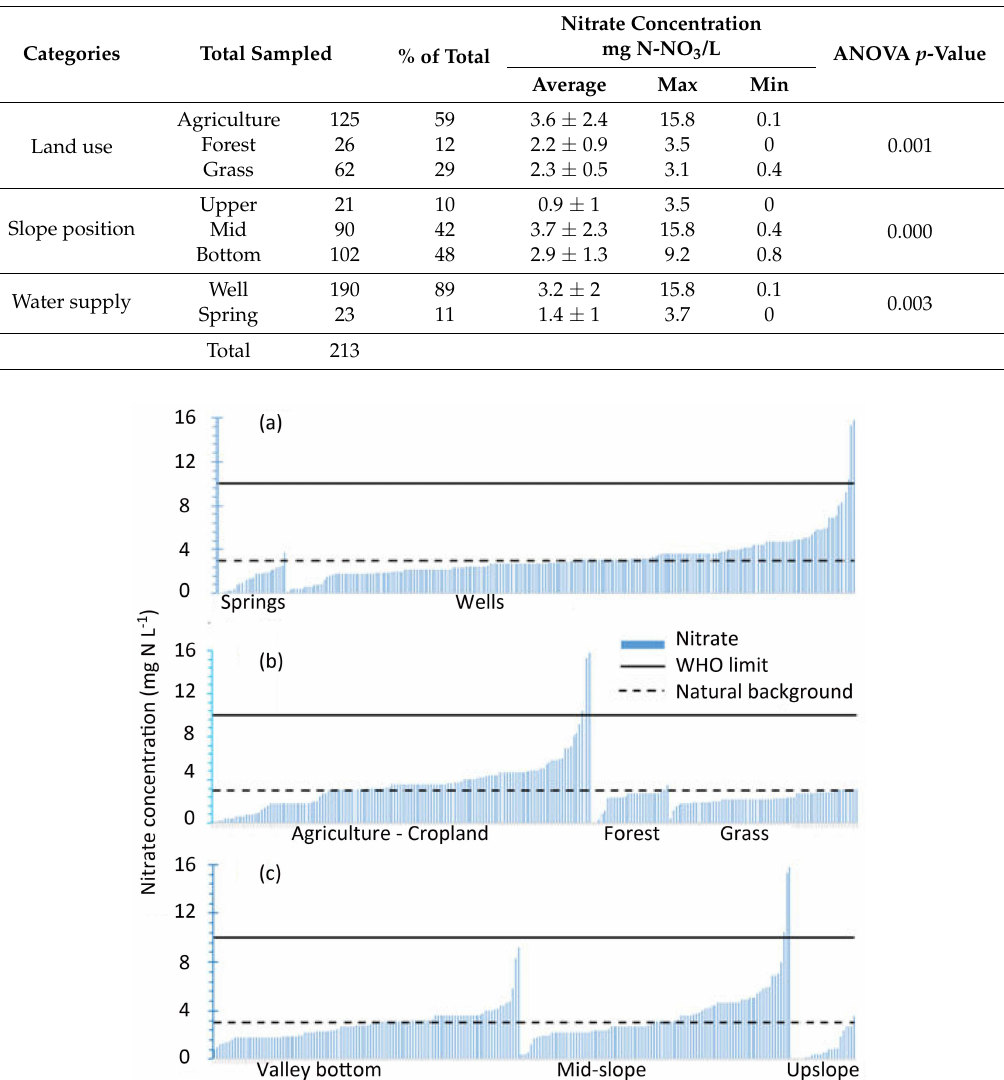
Table 4. Groundwater nitrate concentration based on land use, topographic position and water sources, and ANOVA analysis results.